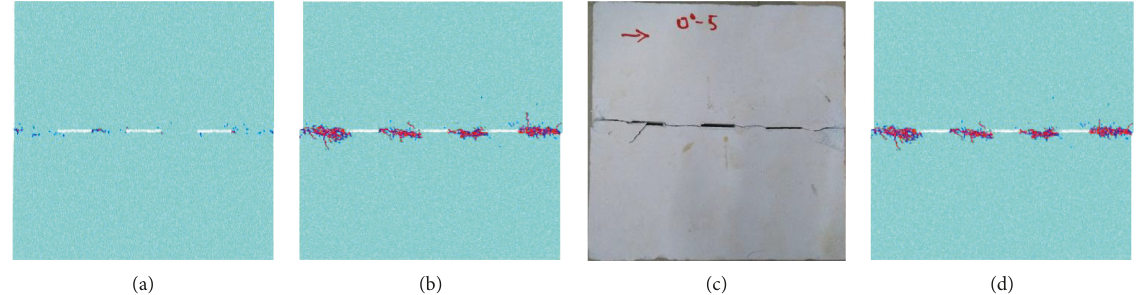
Figure 14: Fracturing process of Sample B0. (a) Point A. (b) Point B. (c) Real failure. (d) Point C.